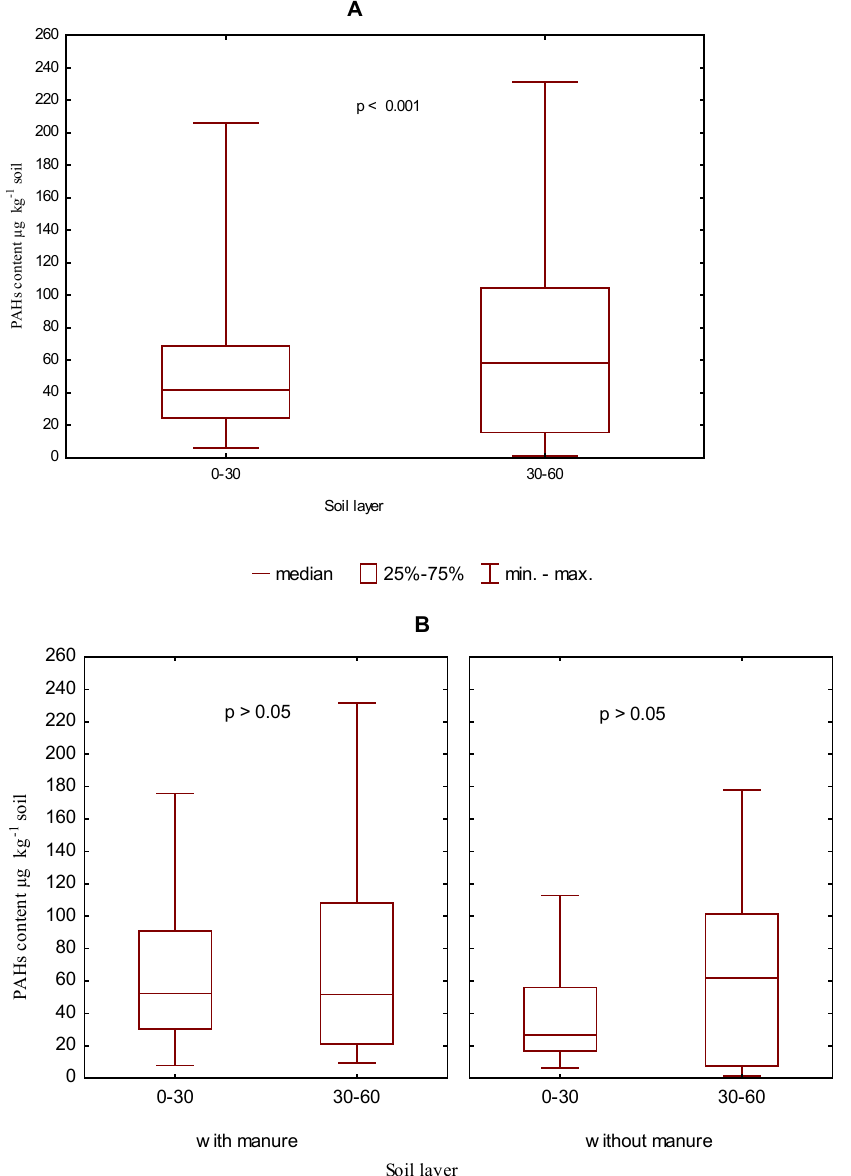
Figure 4. The content of the sum of light PAHs in the soil in 2006–2009 depending on the soil layer ( A ). The 0–30 and 30–60 cm and manure fertilization ( B ) in µg kg − 1 . The comparison of the content of light PAHs in the two soil layers (0–30 and 30–60 cm) in each variant of fertilization proved the lack of significance of the differences (Figure 5). However, a higher content tended to be determined in the lower than in the upper soil layer.